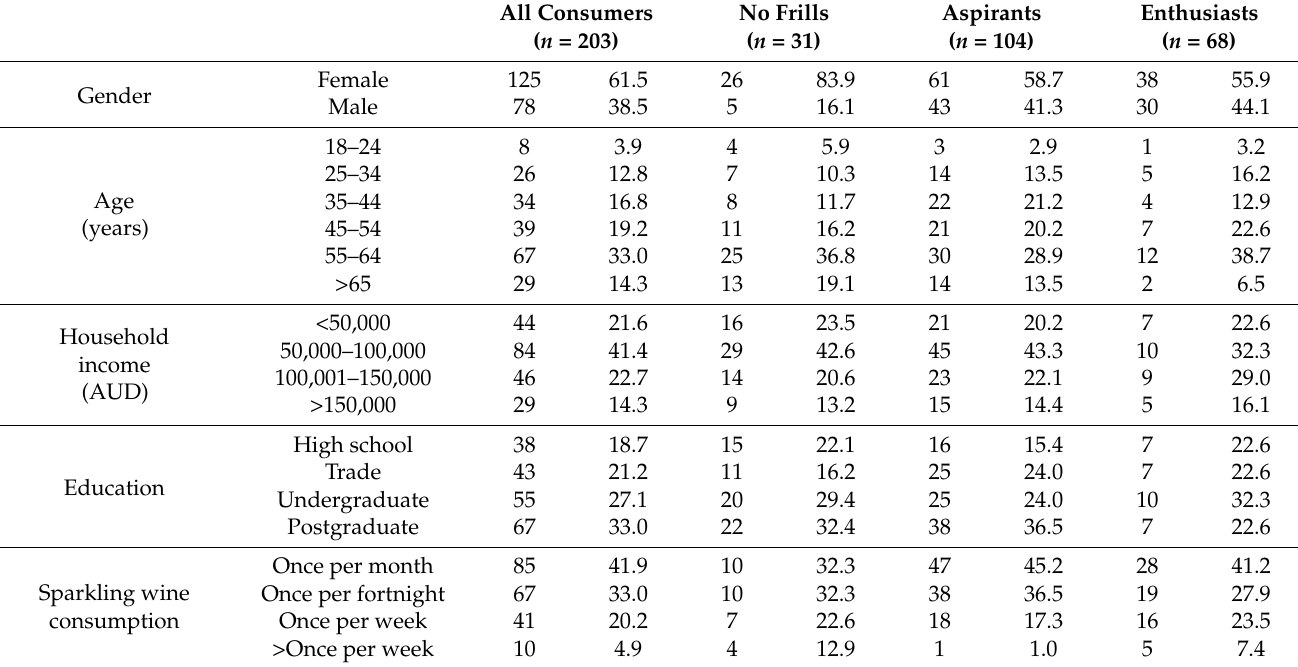
Table 3. Demographics and sparkling wine consumption of consumers and of Fine Wine Instrument consumer segments. Data represent response number (frequency) and proportion